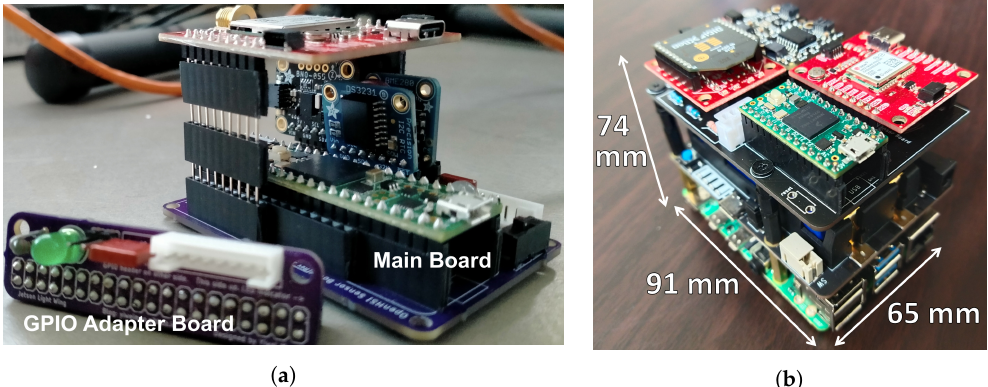
Figure 6. OpenHSI ancillary sensors. ( a ) The GPIO adapter board and main board populated with sensors. ( b ) Updated PCB stacked on top of a Raspberry Pi4 with a battery hat. The whole assembly was 260 g.